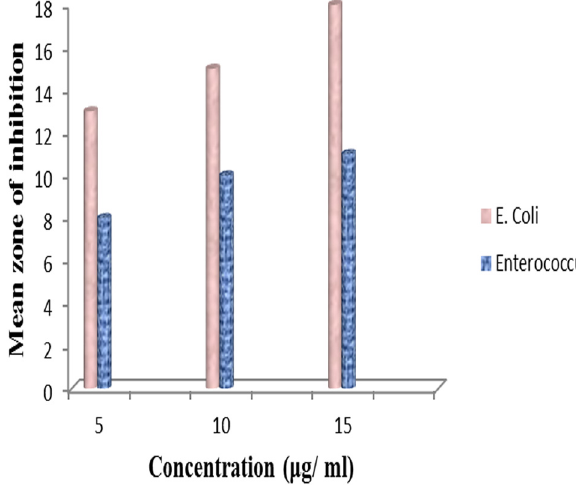
Figure 6: Antibacterial activity of the green TiO 2 NPs and the values of inhibition zones ( mm )